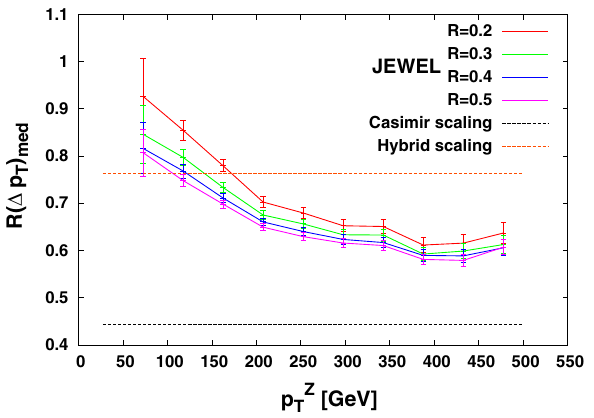
Fig. 5 R (Δ p T ) med asafunctionoftheinitialparton p T forthesamples with hadronization